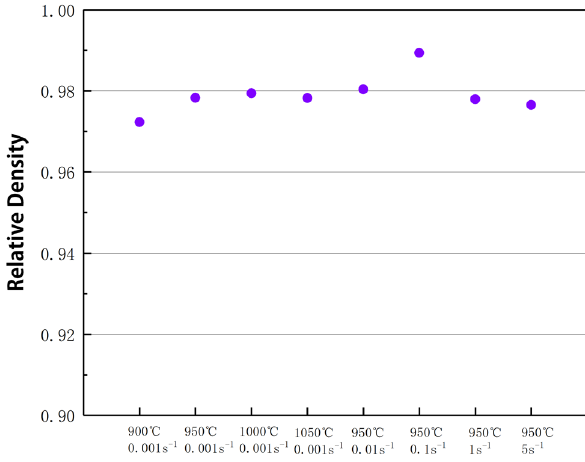
Figure 1: Relative density of TC4 titanium alloy at di ff erent temperatures and strain rates after hot deformation.